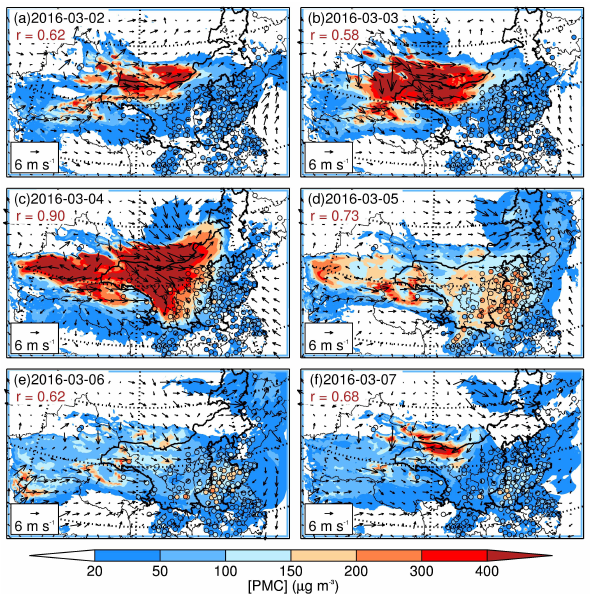
Figure 5. The distribution of calculated (color contour) and ob- served (colored circles) daily average [PMC], along with the sim- ulated wind fields (black arrows). The correlation coefficient ( r ) of linear regression between measured and simulated surface [PMC] is indicated in